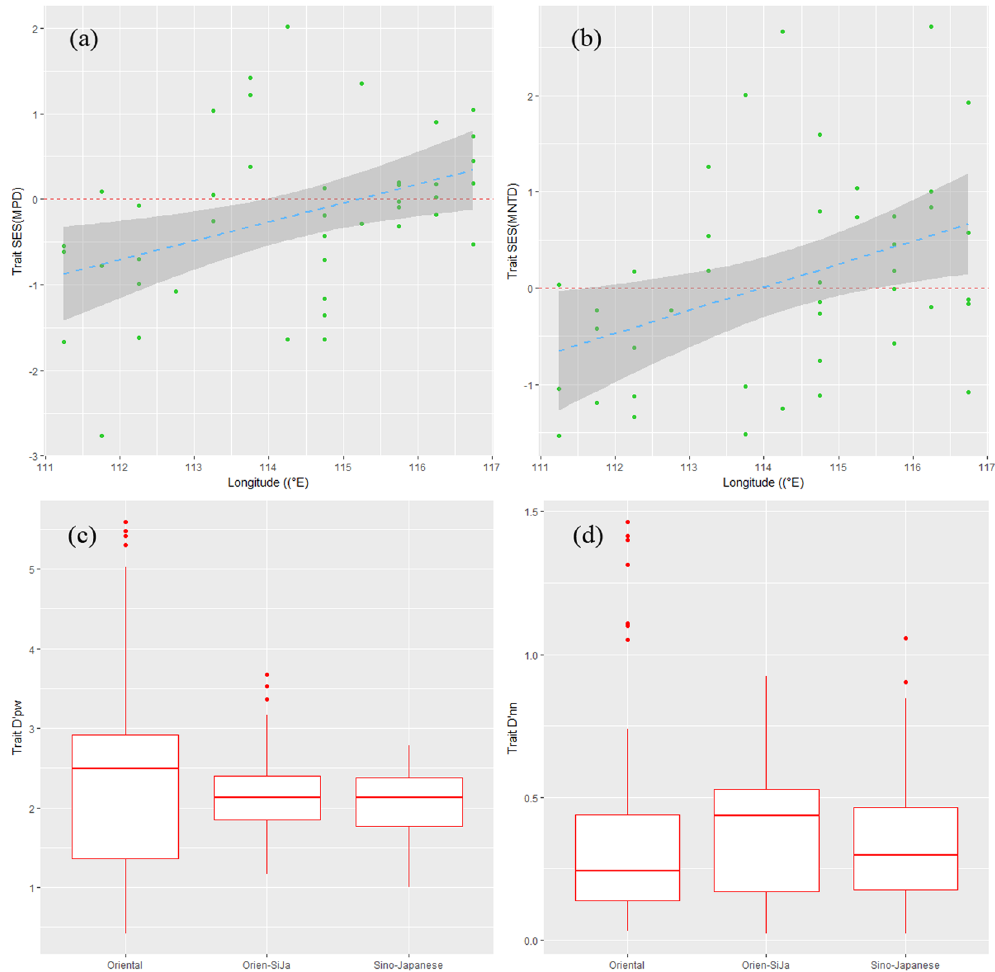
Figure 2. Patterns of functional structure for wintering waterbirds across geographical regions. ( a ) Trait SES (MPD) and ( b ) Trait SES (MNTD) showing cluster at west (111°00 ′ –112°59 ′ ) and overdispersion at east (115°00 ′ –116°59 ′ ),fitted by using GLM. ( c ) Trait D ′ pw at west showing significant higher than east (P adj < 0.01 and ( d ) D ′ nn at west showing lower than east (P adj =